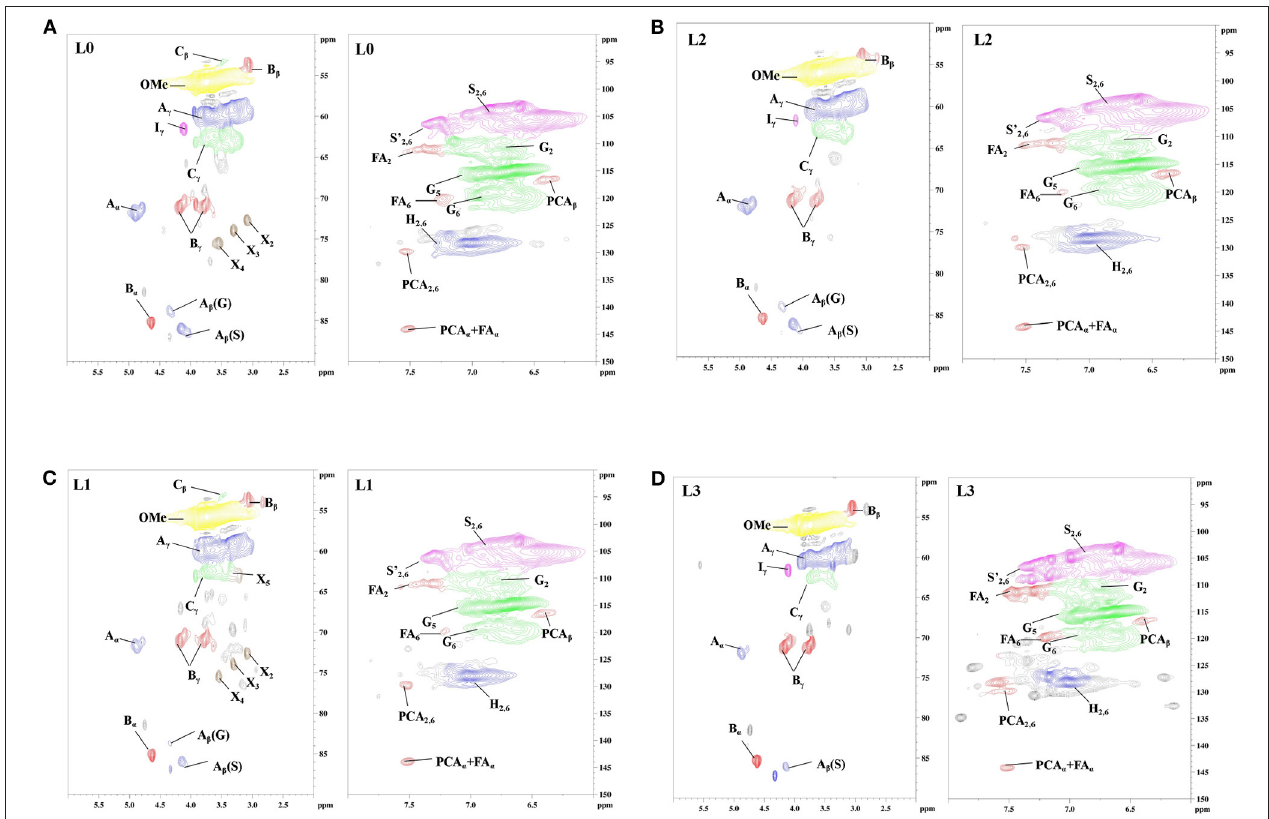
FIGURE 1 | The 2D-HSQC NMR spectra of lignin ( A : L0; B : L1; C : L2; D : L3).